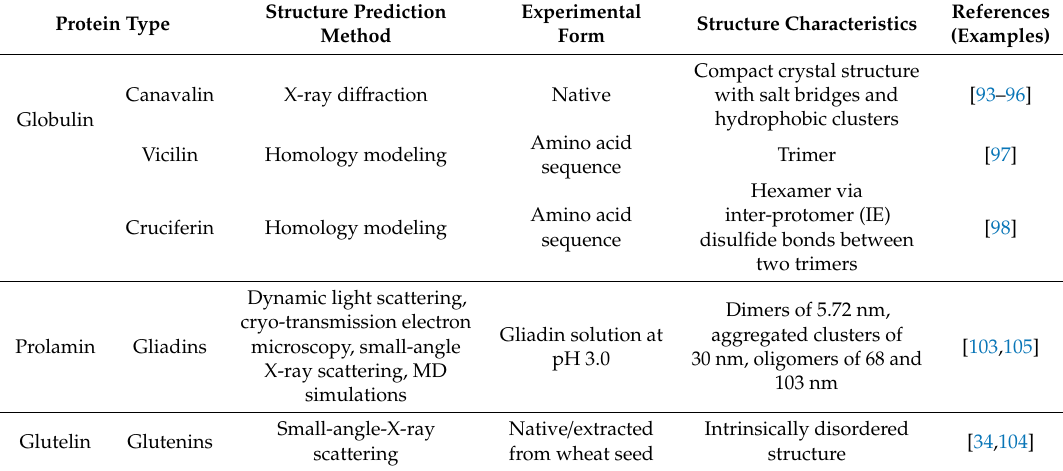
Table 4. Structural characteristics of some modeled seed storage